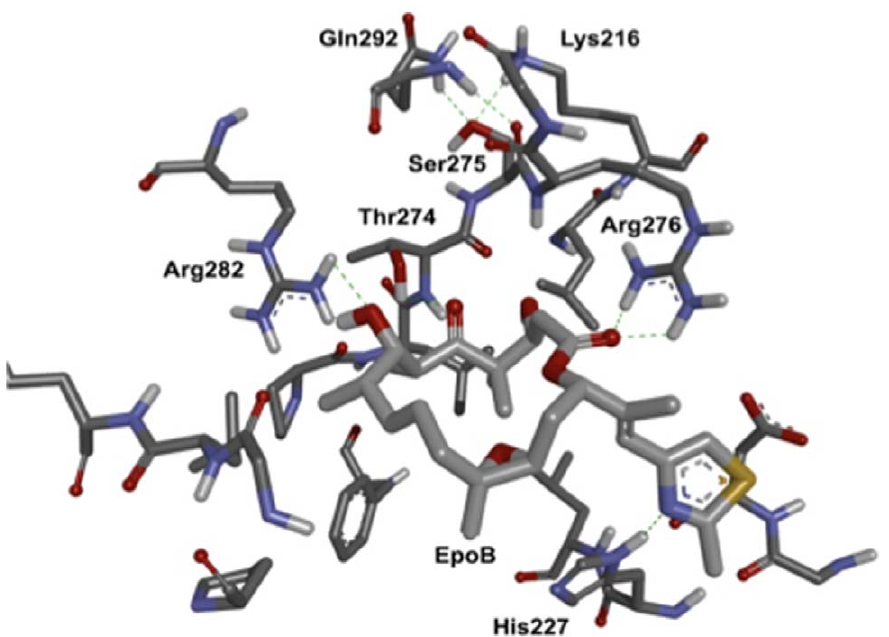
Figure 5. The putative binding pocket (all residues within 6 A˚ of the ligand) of tubulin (1TVK), with epothilone B (modified from epothilone A in 1TVK). Epothilone B is shown as sticks (light grey carbons). The binding pocket residues of 1TVK are shown as sticks (dark grey carbons). Non-polar hydrogens are omitted for clarity. Hydrogen bonds are shown as dashed green lines. Ser275 can form 3 hydrogen bonds with Gln292 and Lys216. Images generated in DS Modelling 3.0 (Accelrys H